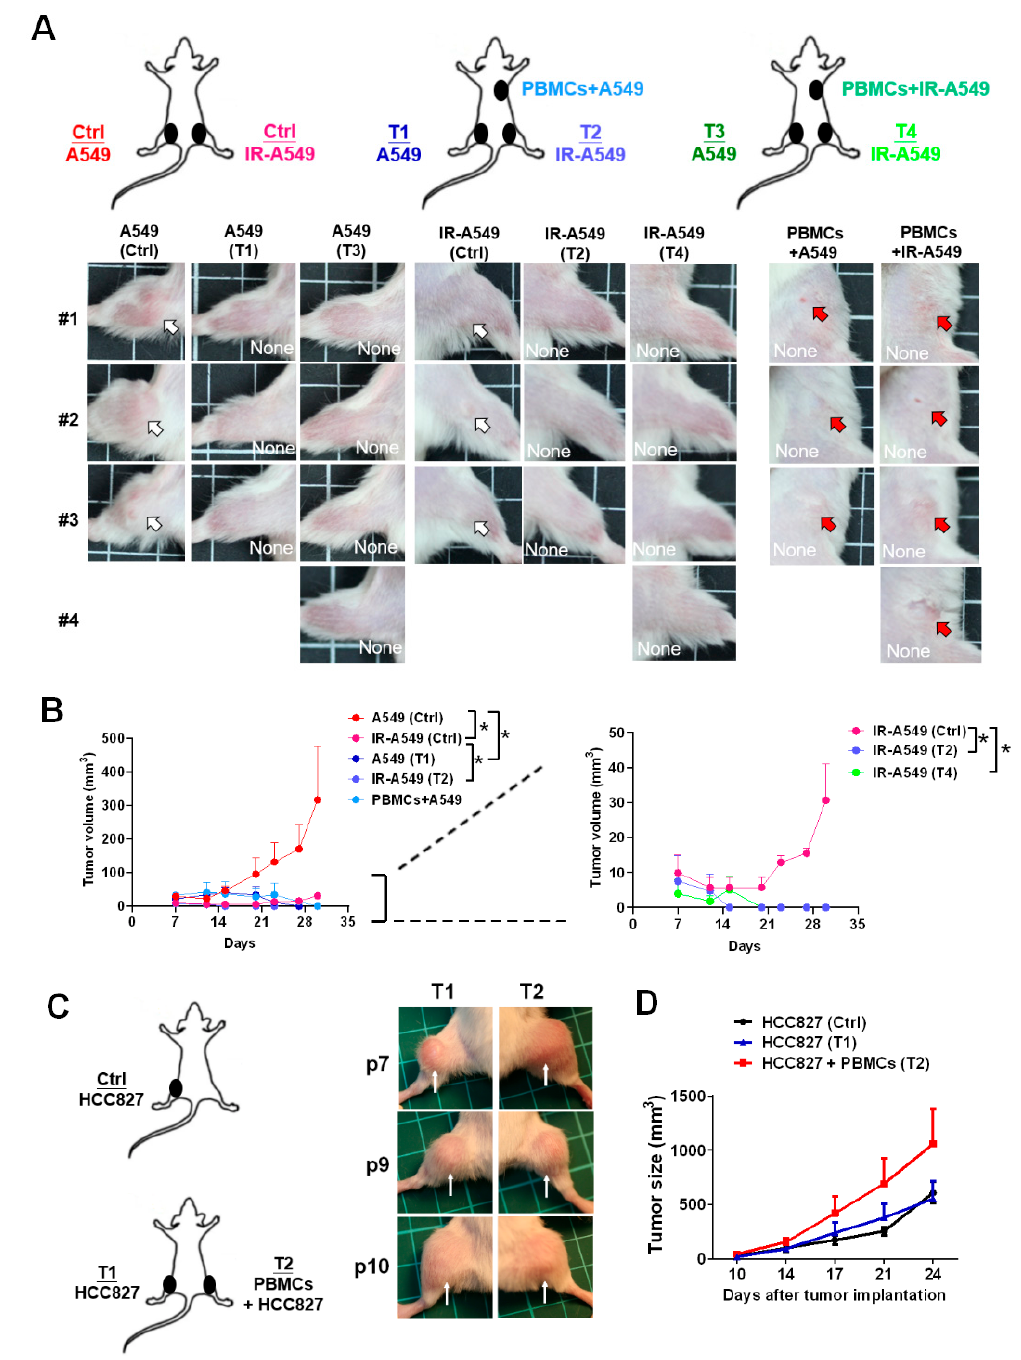
Figure 6. Healthy PBMCs con-injected with tumor cells significantly inhibited A549 tumor growth. ( A ) The A549 or irradiation (IR)-treated A549 cells were injected subcutaneously in a mouse to establish the tumor xenografts. Meanwhile, PBMCs with A549 or irradiated A549 were co-injected subcutaneously on the back. The tumor images at day 30 were captured and shown. ( B ) The tumor burdens were measured and compared consequently by day 7, 12, 15, 20, 23, 27, and 33, whereas control mice: n = 3, PBMCs + A549: n = 3, PBMCs + IR-A549: n = 4. ( C ) The anti-tumor effect of PBMCs from the patients with lung cancer (n = 3, P7, P9, and P10 in Table 1) was investigated in an HCC827-derived tumor xenograft model. The control group: n = 3. The tumors at day 24 for T1 and T3 were shown, ( D ) and the tumor sizes were recorded on day 10, 14, 17, 21, and 24. Tumors are indicated by arrows. Tumor volumes were calculated according to the formula: 0.52 × width 2 × length, herein the width represents the smaller tumor diameter. * p <